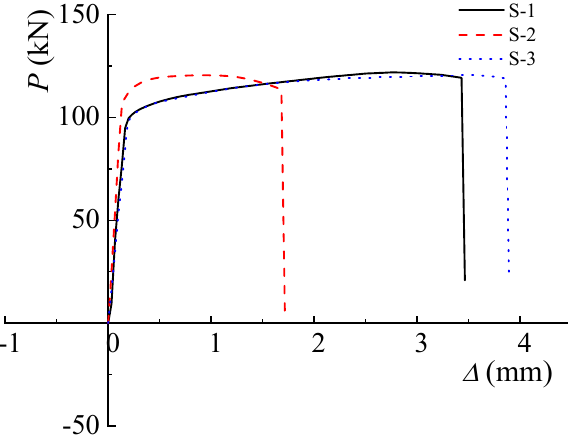
Figure 8. Load–displacement curve of monotonic tensile test.